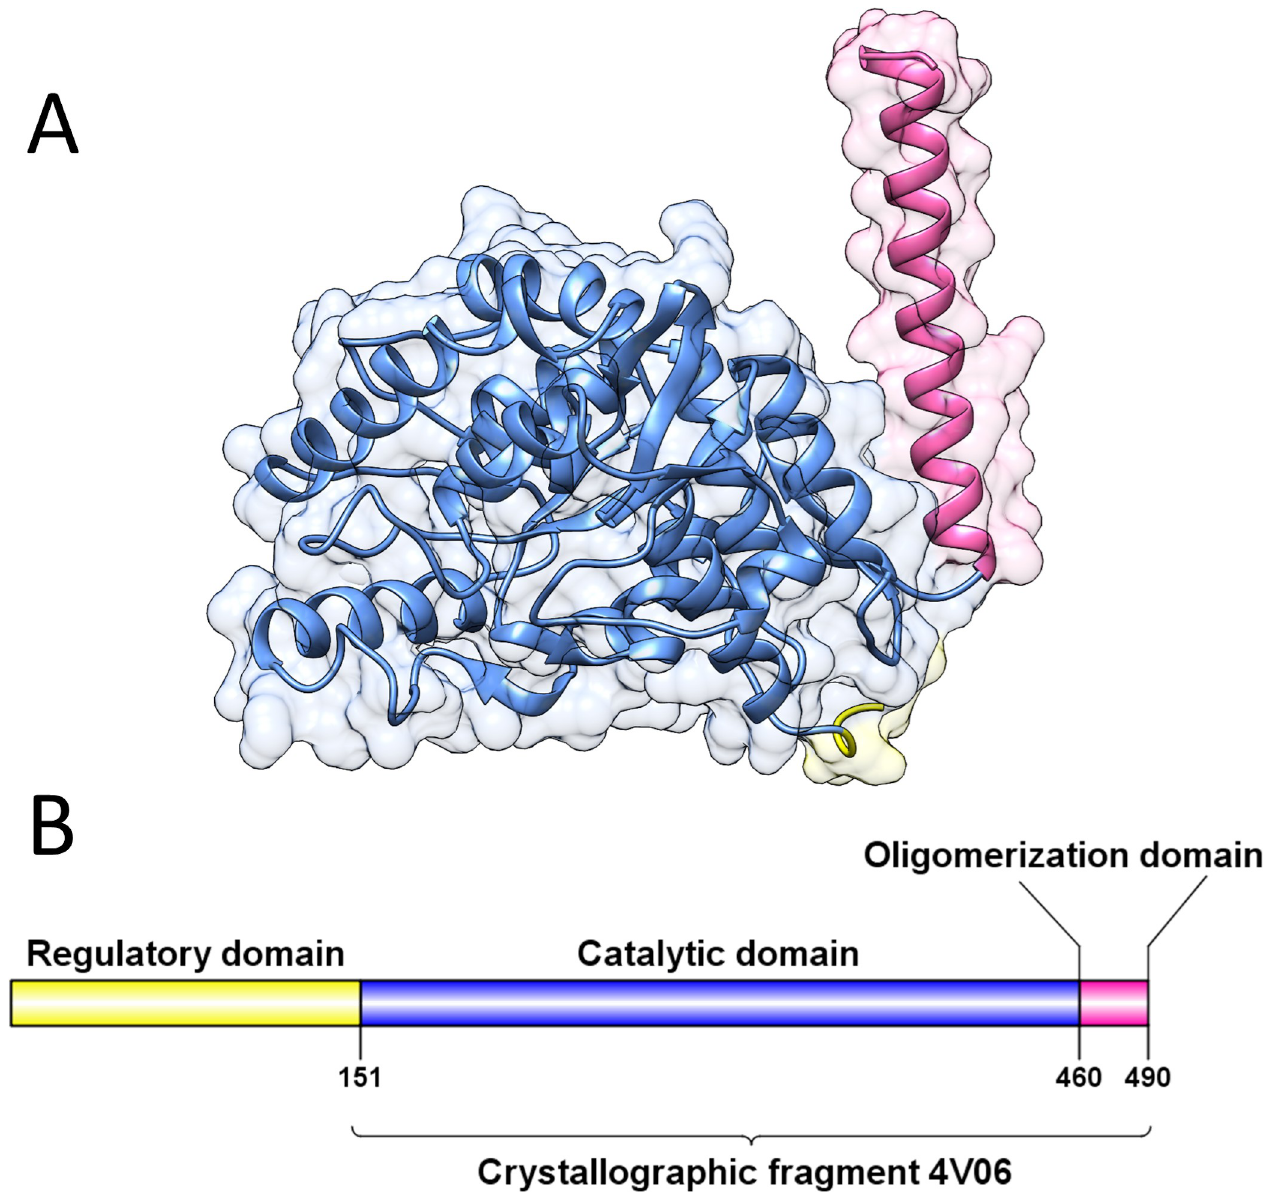
Fig 1. Crystallographic structure and schematic representation of TPH2. The regulatory, catalytic and oligomerization domains of TPH2 are represented in yellow, blue and pink, respectively. (A) Secondary structure representation of the crystallographic structure of TPH2 (PDB ID: 4V06). The protein surface is also shown. (B) Schematic representation of TPH2. The region corresponding to the experimentally determined structure of TPH2 is indicated by the